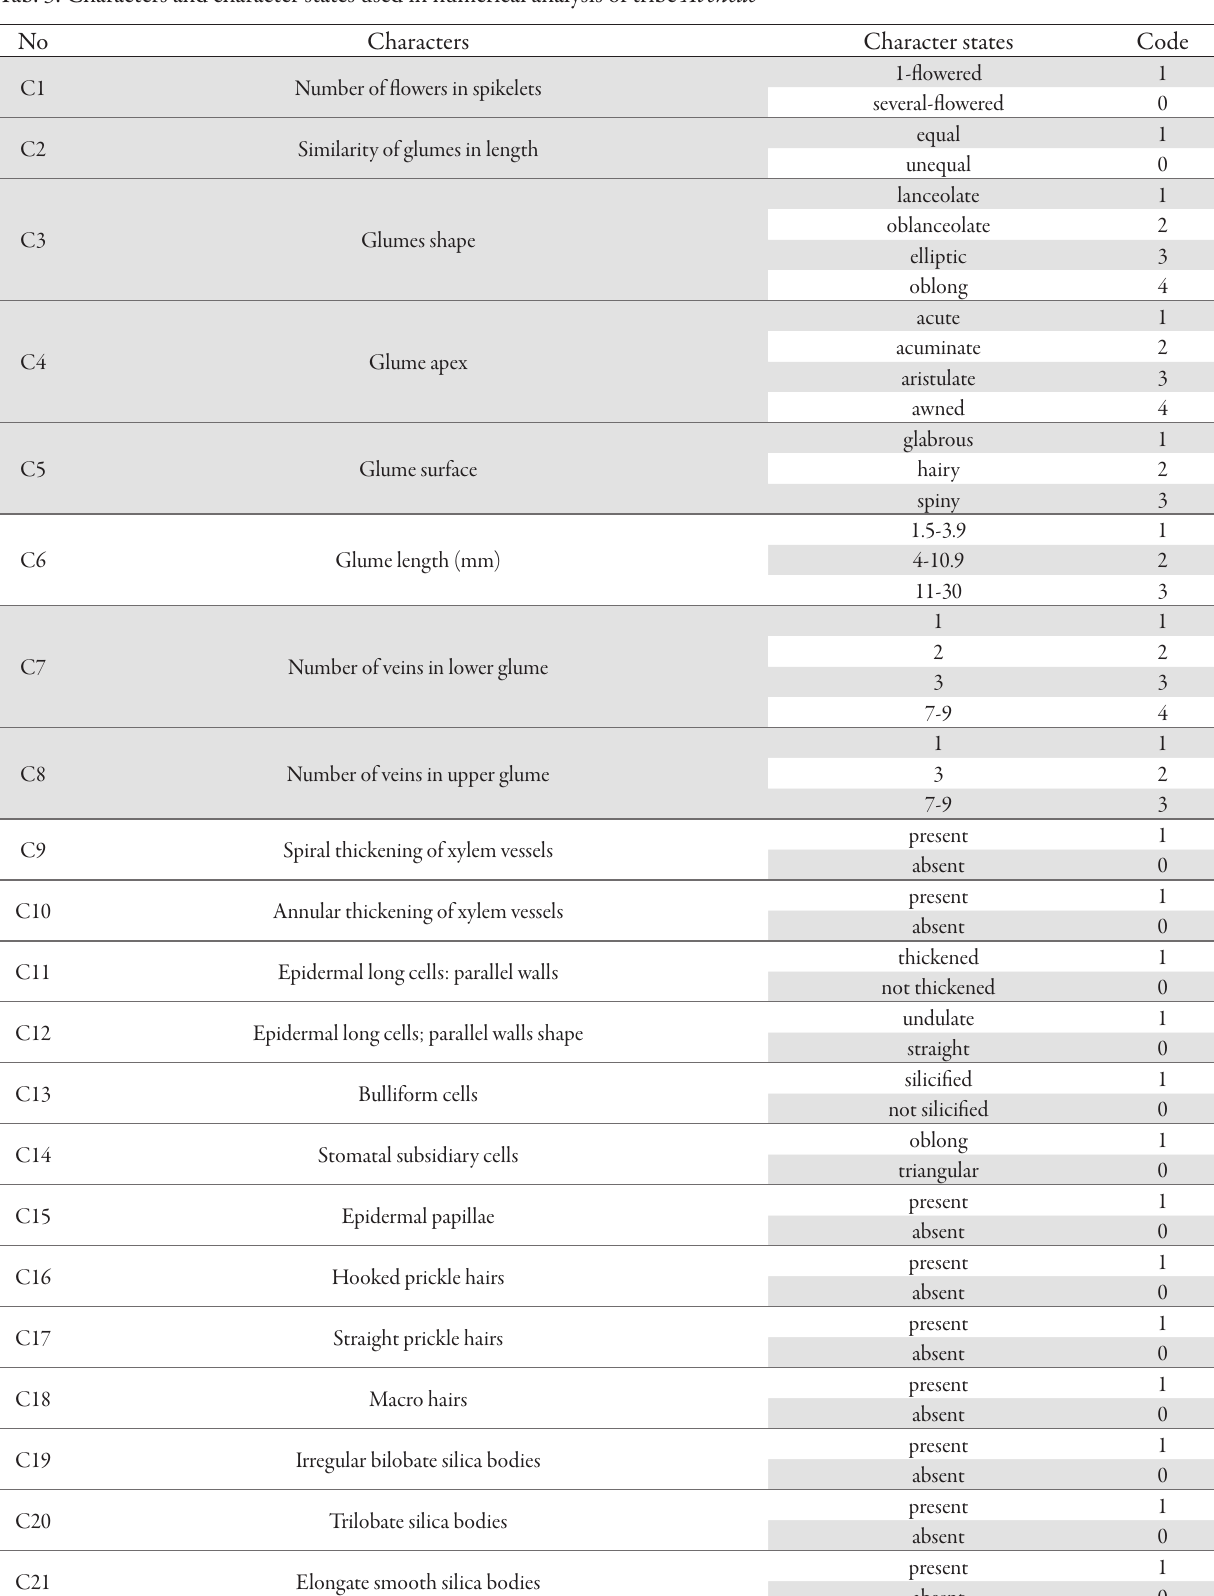
Tab. 3. Characters and character states used in numerical analysis of tribe Aveneae